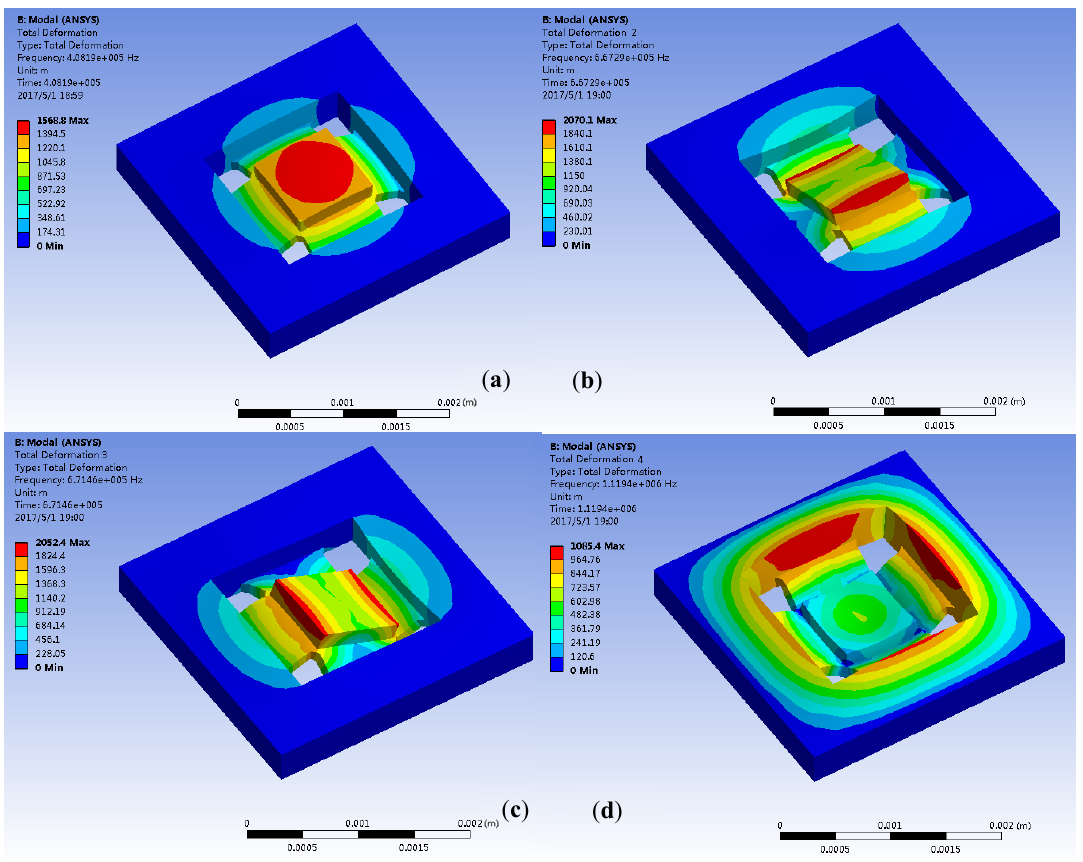
Figure 3. Mode simulation of HGMA structure ( a – d ) are 1st, 2nd, 3rd and 4th order modes.